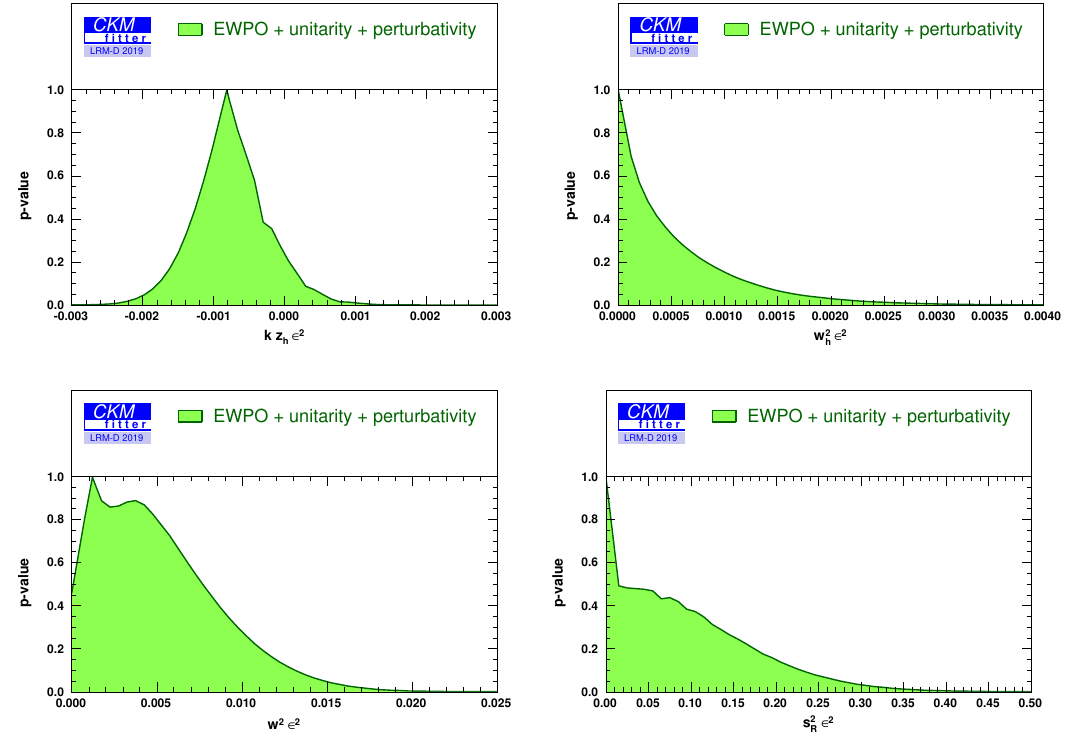
Figure 8 . The p -values for some parameters of the